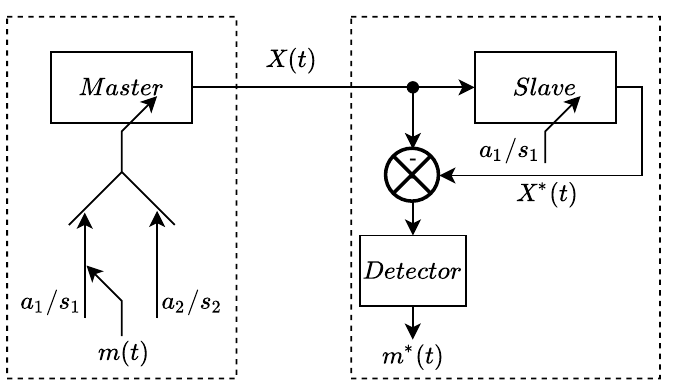
Figure 1. Block diagram of the communication system with parameter modulation (PM)/symmetry coefficient modulation (SCM), where a 1 or s 1 and a 2 or s 2 are the parameter or symmetry coefficient values corresponding to a certain binary symbol during binary message transmission